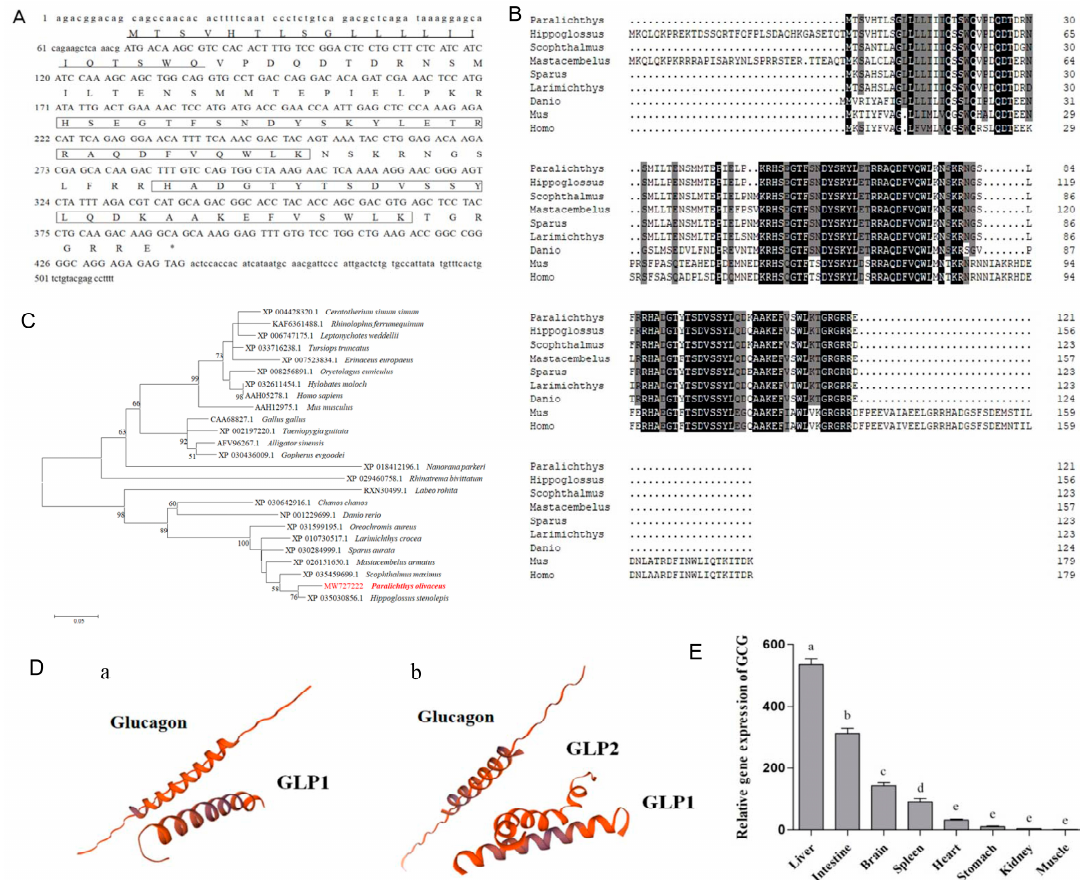
Figure 1. Gene cloning, functional analysis, and tissue distribution of GCG. ( A ), Nucleotide sequence, deduced amino acid sequence, and predicted domains of the GCG gene. The signal peptide is marked with a black underline; the GLUCA domain is marked with a black box; The asterisk (*) indicatesthe stop codon. ( B ), Comparison of the amino acid sequences of GCG. Comparison of the deduced amino acid (aa) sequence of GCG from Japanese flounder with those from other fish, mouse, and human. The aa sequences were aligned using ClustalW, and similarity shading was based on a 75% identity threshold. Identical residues are shaded dark, and similar residues are shaded light. Accession numbers: Hippoglossus stenolepis (XP_035030856.1); Scophthalmus maximus (XP_035459699.1); Mastacembelus armatus (XP_026151650.1); Sparus aurata (XP_030284999.1); Larimichthys crocea (XP_010730517.1); Danio rerio (NP_001229699.1); Mus musculus (AAH12975.1); Homo sapiens (AAH05278.1). ( C ), NJ phylogenetic tree based on amino acid sequences. The phylogenetic tree is based on these sequences: Ceratotherium simum simum (XP_004428320.1); Rhinolophus ferrumequinum (KAF6361488.1); Leptonychotes weddellii (XP_006747175.1); Tursiops truncates (XP_033716238.1); Erinaceus europaeus (XP_007523834.1); Oryctolagus cuniculus (XP_008256891.1); Hylobates moloch (XP_032611454.1); Homo sapiens (AAH05278.1); Mus musculus (AAH12975.1); Gallus gallus (CAA68827.1); Taeniopygia guttata (XP_002197220.1); Alligator sinensis (AFV96267.1); Gopherus evgoodei (XP_030436009.1); Nanorana parkeri (XP_018412196.1); Rhinatrema bivittatum (XP_029460758.1); Labeo rohita (RXN30499.1); Chanos chanos (XP_030642916.1); Danio rerio (NP_001229699.1); Oreochromis aureus (XP_031599195.1); Larimichthys crocea (XP_010730517.1); Sparus aurata (XP_030284999.1); Mastacembelus armatus (XP_026151650.1); Scophthalmus maximus (XP_035459699.1); Paralichthys olivaceus (MW727222); Hippoglossus stenolepis (XP_035030856.1); The red words represent Japanese flounder. ( D ), Schematic diagram of the three-dimensional structure of the GCG protein from Japanese flounder and human. ( a ) GCG in Japanese flounder; ( b ) GCG in human. ( E ), Tissues distribution of GCG in Japanese flounder. The values represent the means ± S.E., n = 3, one-way ANOVA with Tukey post-hoc test. Values with different letters mean statistical differences ( p <